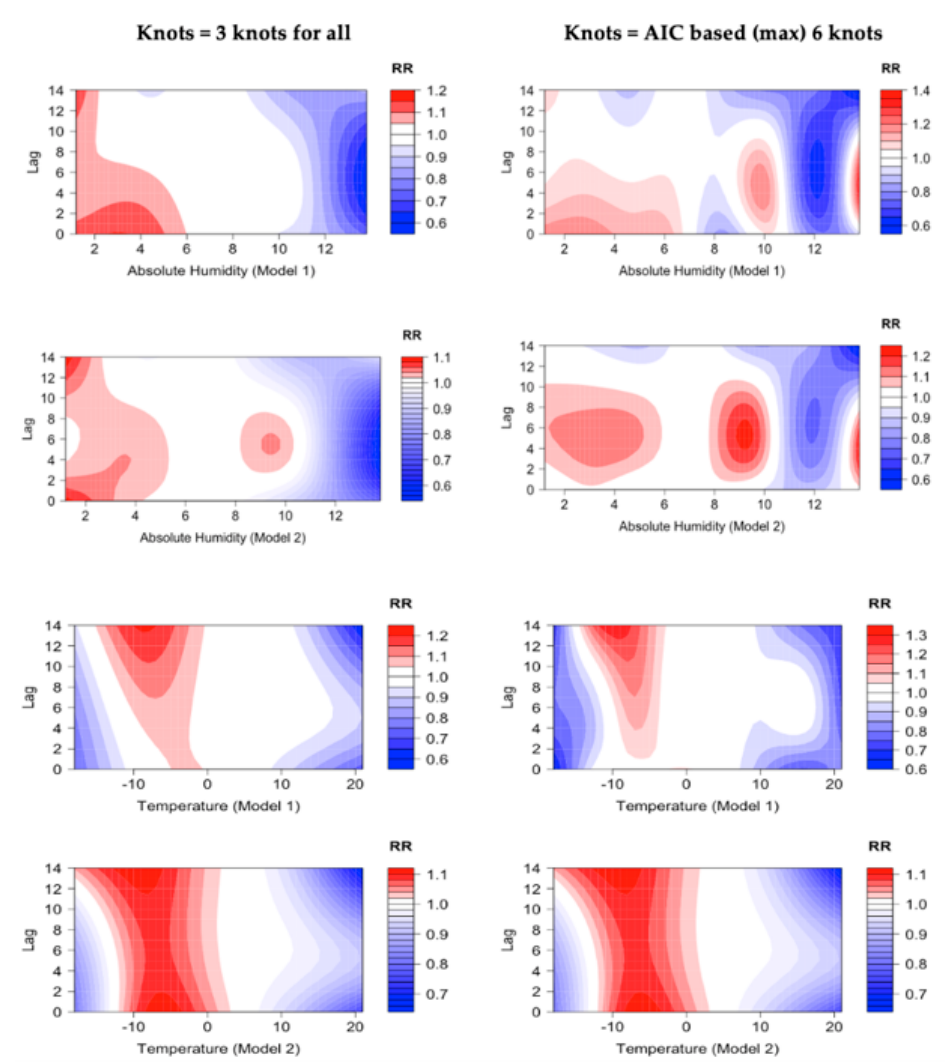
Figure 3. Relative risks of COVID-19 by absolute humidity, daily mean temperature, and time lag, compared to the reference values of 7 g/m 3 and 5 °C. The figures present RR for Models 1 and 2 with up to 14-day lag in the Helsinki-Uusimaa hospital district (HUS) from 1 August 2020 until 31 May 2021. Left panels: the number of knots for the exposure–response function was fixed at three knots. Right panels: the number of knots were based on the lowest AIC with a maximum limit of six knots. Increased RR is presented as red, decreased RR as blue, and white indicates no significant difference.